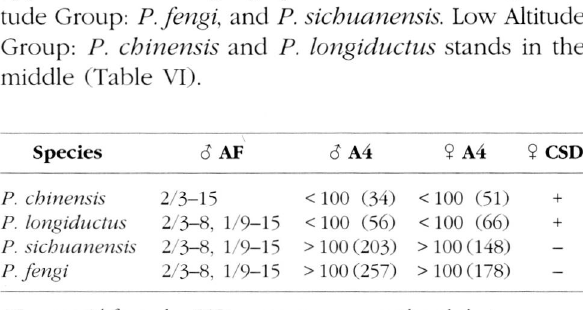
Table VI. - Some morphological differences in Chinese Adlerius.